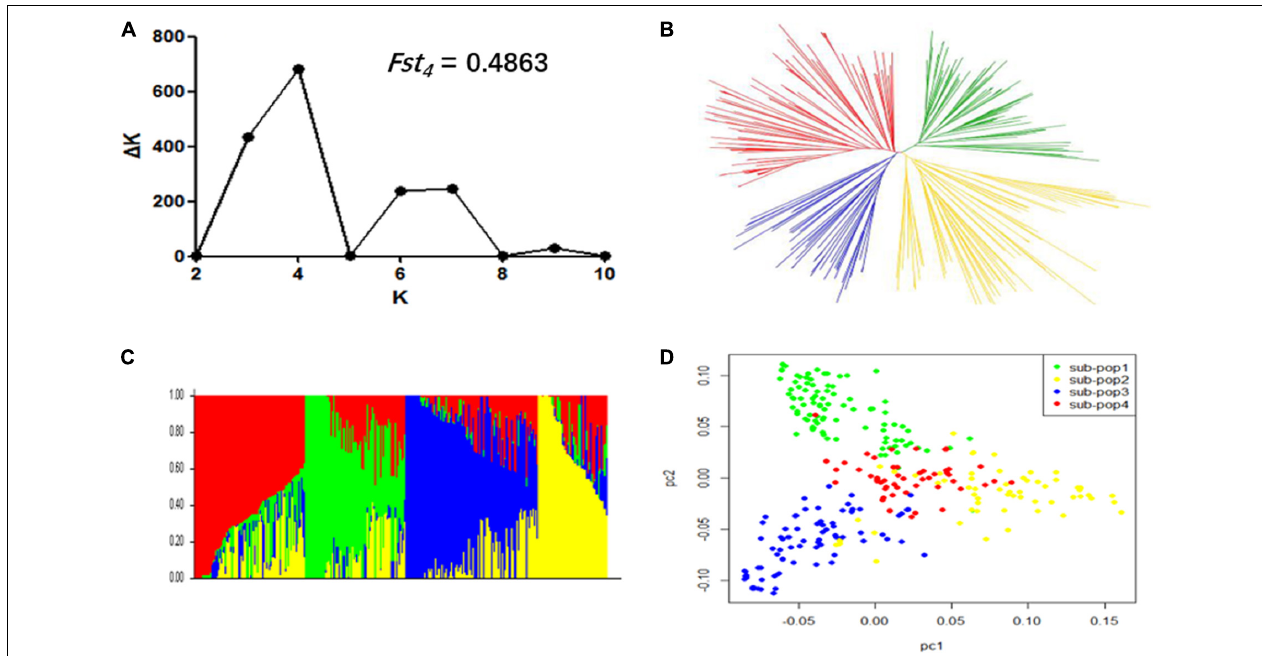
FIGURE 2 | Population structure of 309 soybean accessions. (A) Calculation of the true K of the YHSBLP following procedure outlined by Evanno et al. (2005). (B) A neighbor-joining tree of the tested accessions that could be divided into four subpopulations. (C) Population structure derived from STRUCTURE software. Four colors (blue, yellow, green, and red) represent the four subpopulations (subpopulation 1, 2, 3, and 4, respectively). Each vertical column represents one individual and each colored segment in each column represents the percentage of the individual in the population. (D) Principal component analysis plot of the 309 accessions; two-dimensional scales were used to reveal population stratification.